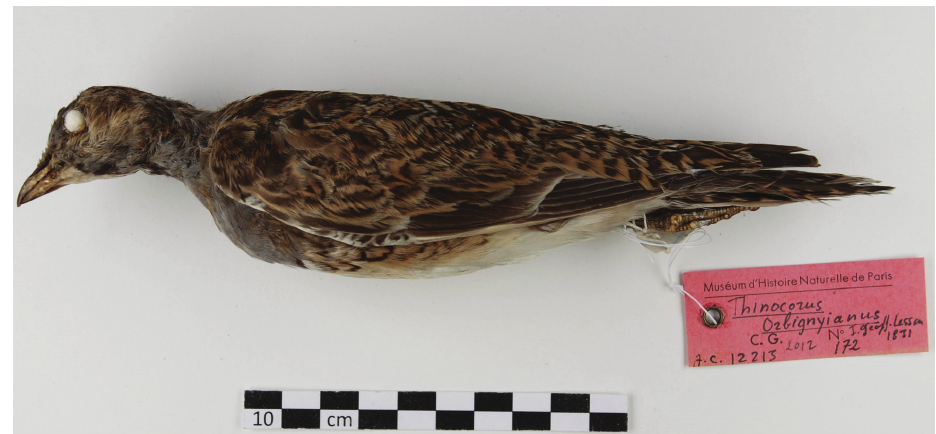
Figure 4: Thinocorus Orbignyianus (male), collected by Gay in Santiago, Muséum d’Histoire naturelle .